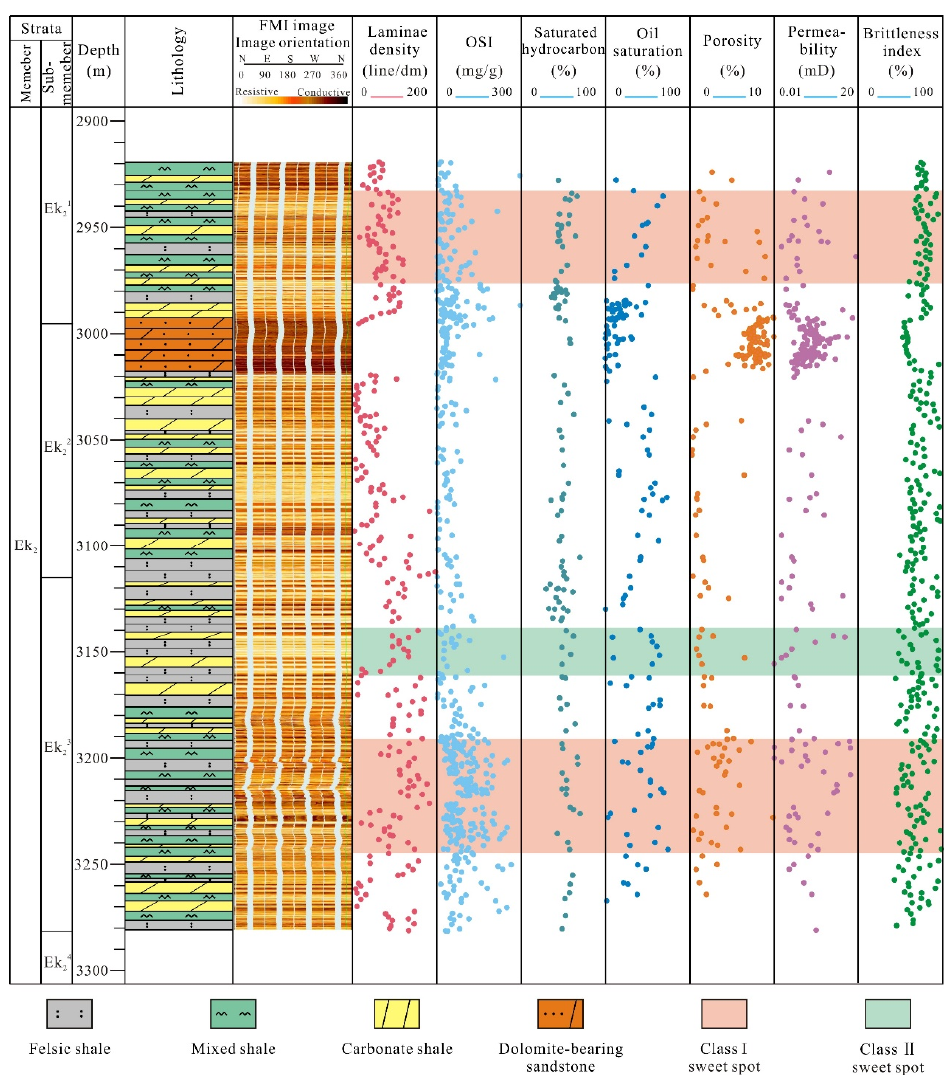
Figure 16. Comprehensive evaluation of sweet spot intervals of the Ek 2 shale oil in the Cangdong